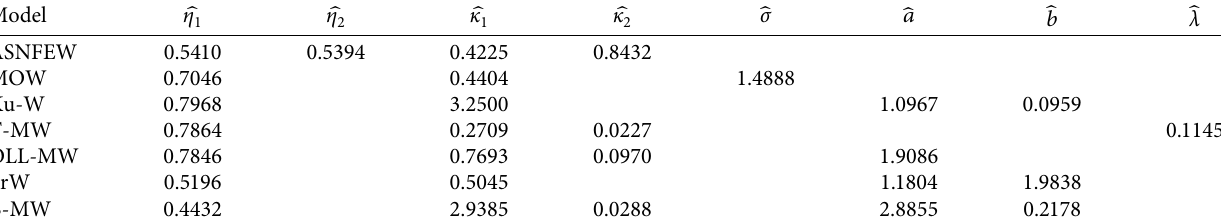
Table 4: The estimated values of the parameters corresponding to COVID-19